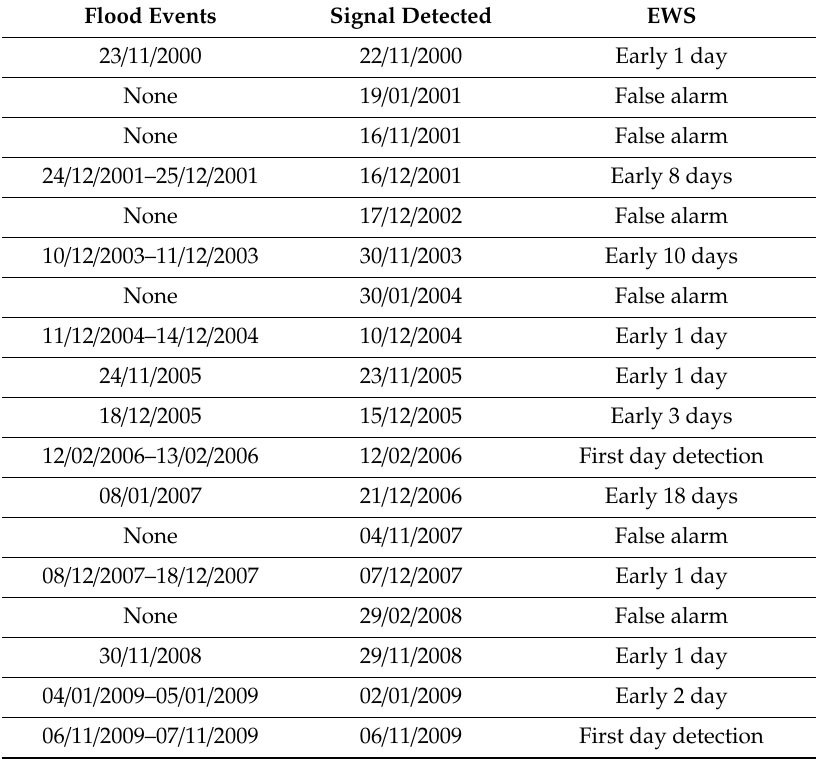
Table 5. Results of EWS from the water level data with the optimum threshold at the quantile 15%. Flood